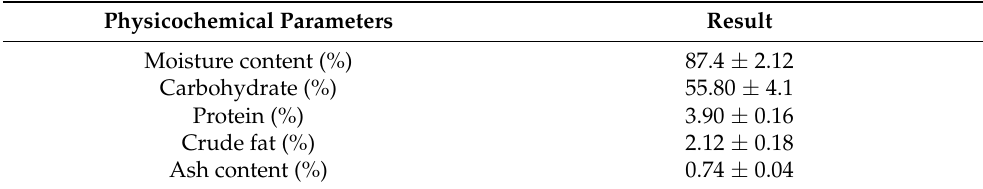
Table 1. Physicochemical parameters of A. nilagirica leaf powder.